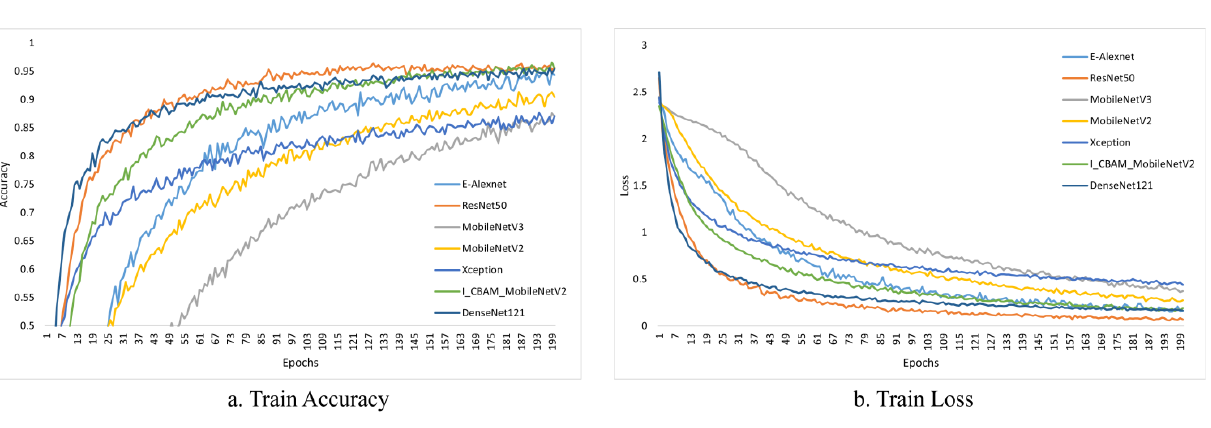
Figure 11. Validation accuracy and loss of different models.